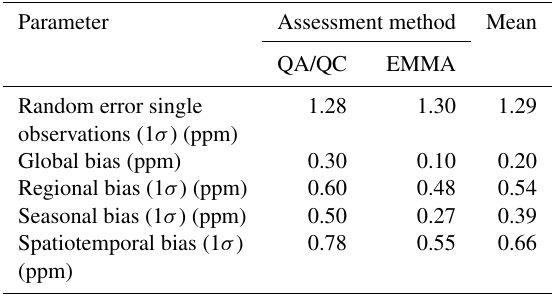
Table 5. Validation summary for data product XCO2_EMMA